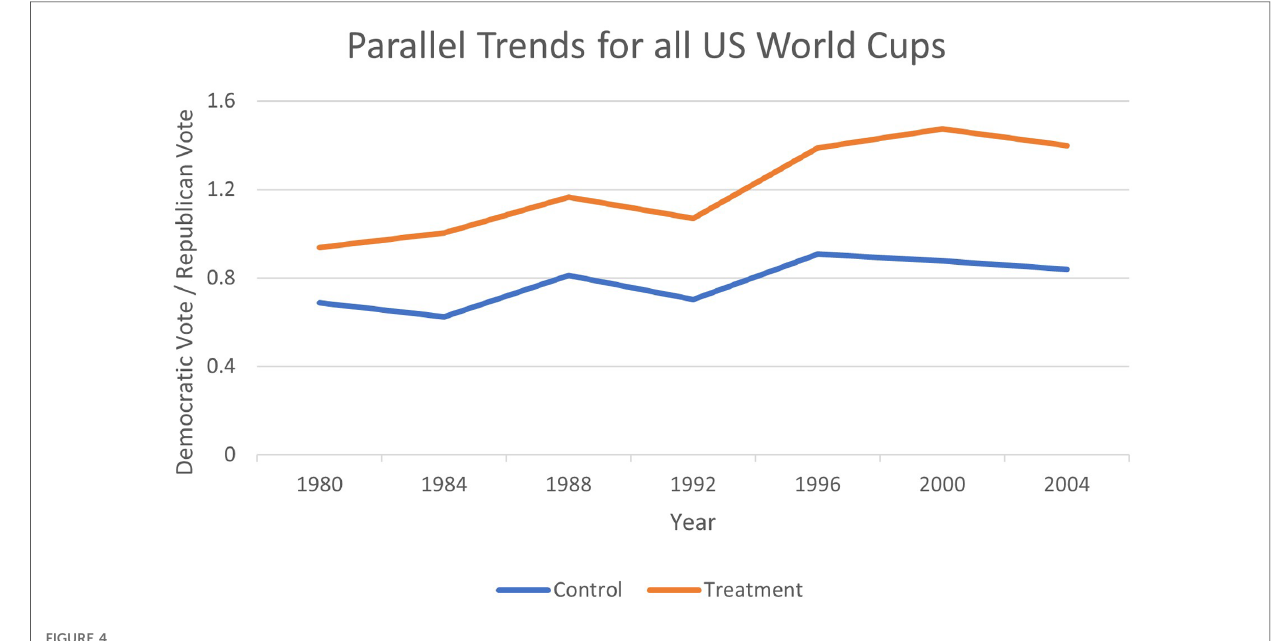
FIGURE 4 Testing parallel trends for all World Cups.